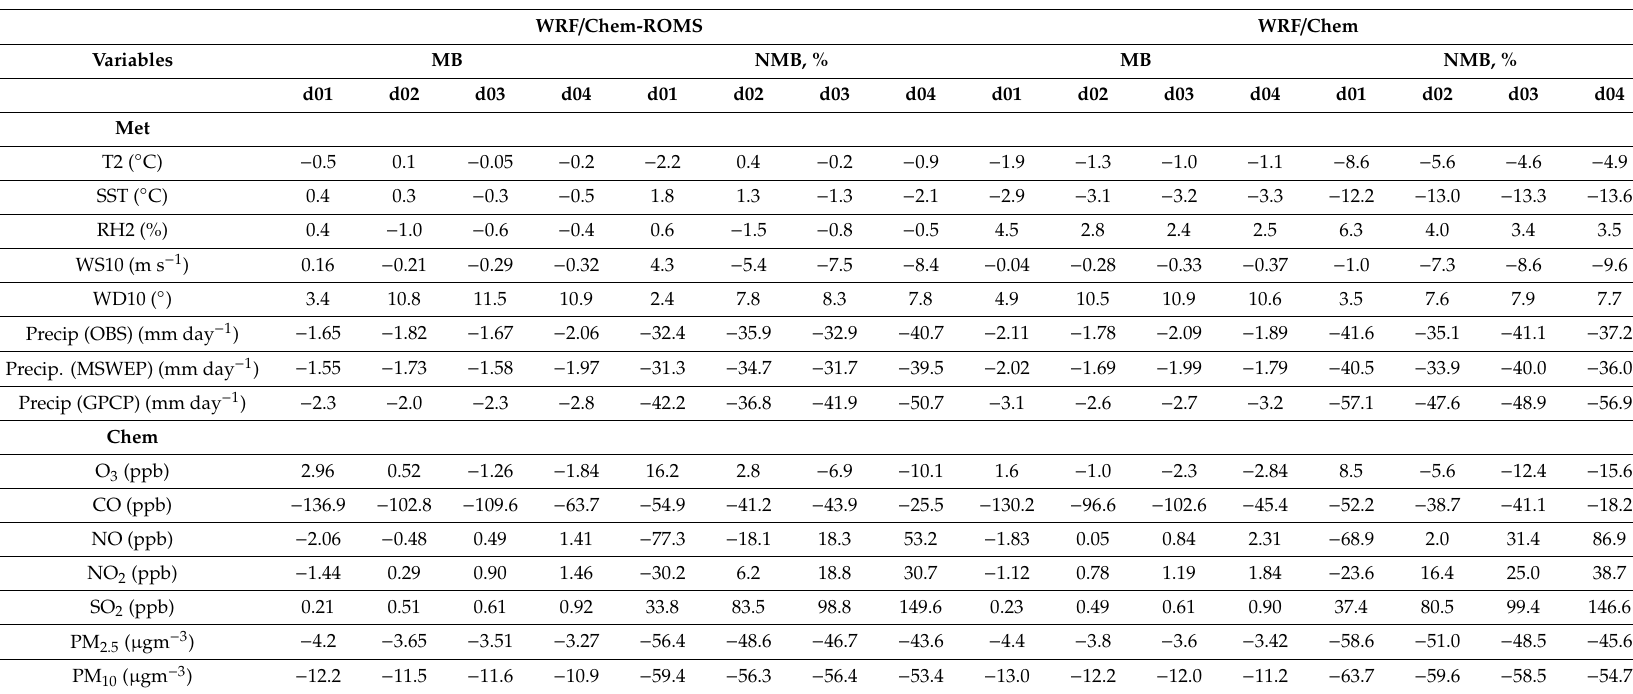
Table 3. Mean bias (MB) and normalized mean bias (NMB) of meteorological and chemical variables from WRF / Chem and WRF / Chem-ROMS simulations at 81 km (d01), 27 km (d02), 9 km (d03), and 3 km (d04) over the 3 km domain (d04) for the MUMBA field campaign. WRF / Chem-ROMS